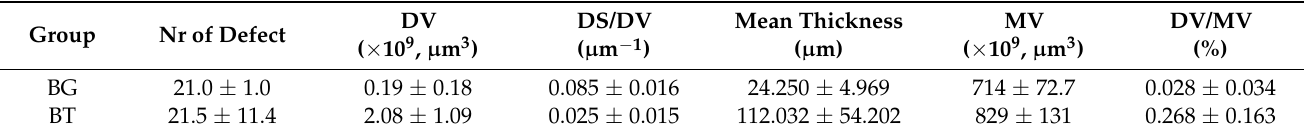
Table 2. Means ± Standard Deviation o (m ± SD) of data obtained by the Defect Analysis Tool of BG and BT groups. Nr of defects (Number of defects), DV (Defect Volume), DS/DV (Defect Surface/Defect Volume), MV (Materials Volume), DV/MV (Defect Volume/Materials Volume).